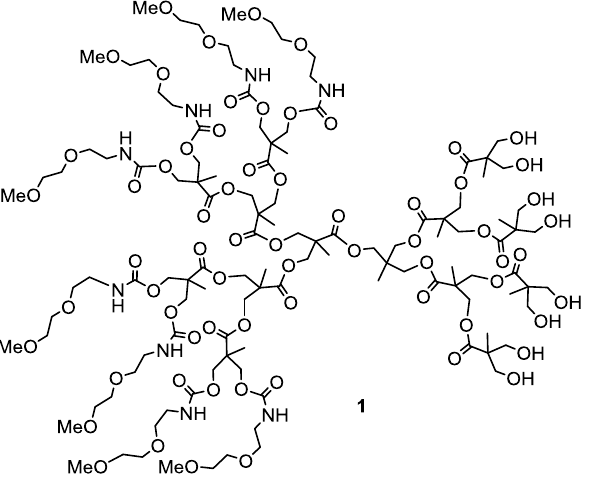
Figure 2. Fréchet’s polyester dendrimer-[poly(ethylene oxide)]. A “Bow-tie” type